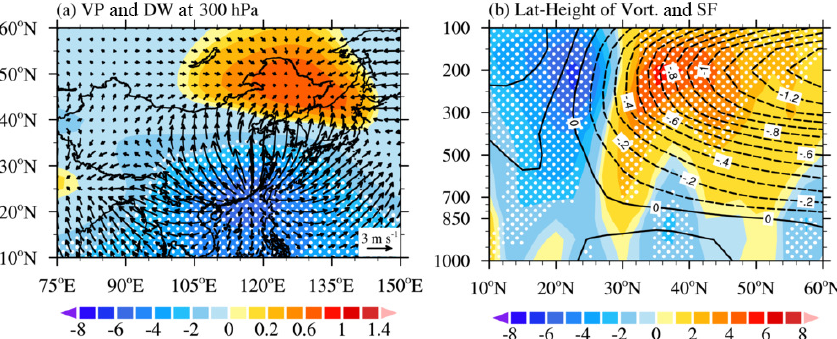
Figure 7. Composite (a) divergent wind (arrows) and velocity potential (shading, unit: 10 6 m 2 s − 1 ) at 200hPa, (b) latitude–height cross section of the stream function (contours, unit: 10 8 m 2 s − 1 ) and relative vorticity (shading, unit: 1 . 5 × 10 − 5 m 2 s − 1 ) averaged over 112– 120 ◦ E, for the 13 SR–NH events. The divergent wind flows from the minimum to the maximum of the velocity potential field. Dotted white regions indicate areas at the 95% confidence level based on the two-tailed Student t test.